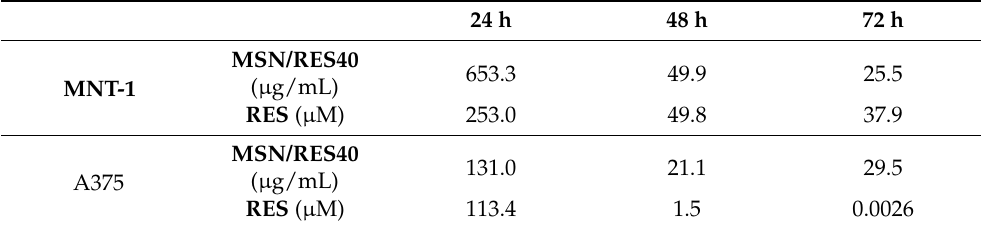
Figure 7. Effect of pristine MSNs, RES-loaded MSNs (0–700 μg/mL), and bulk RES (0–700 μM) on cell viability of MNT-1 and A375 melanoma cells by the 3-(4,5 dimethyl-2-thiazolyl)-2,5-diphenyl tetrazolium bromide (MTT) assay at 24, 48, and 72 h. Results are expressed as mean ± SD. * indicates significant differences between control at p < 0.05 for 24 h; # indicates significant differences between control at p < 0.05 for 48 h; and + indicates significant differences between control at p < 0.05 for 72 h. ( a ) MNT-1 cells exposed to RES-loaded MSNs; ( b ) A375 cells exposed to RES-loaded MSNs; ( c ) MNT-1 cells exposed to pristine MSNs; ( d ) A375 cells exposed to pristine MSNs; ( e ) MNT-1 cells exposed to bulk RES and ( f ) A375 cells exposed to bulk RES. Table 3. Estimation of half maximal inhibitory concentration (IC50) of bulk RES and RES-loaded MSNs to MNT-1 and A375 melanoma